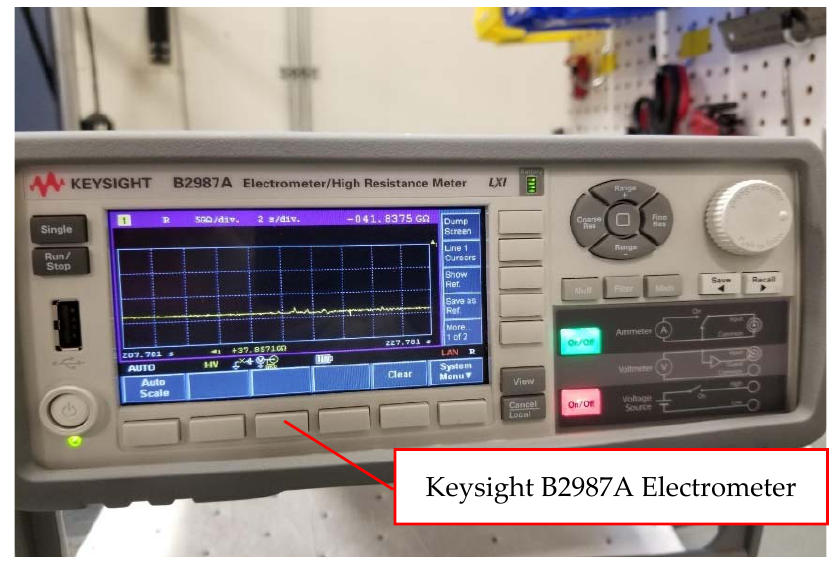
Figure 2. Keysight B2987A Electrometer (Reproduced with Permission, Courtesy of Keysight Tech- nologies, © Keysight Technologies, Inc., Santa Rosa, CA, USA) [34] for measurement of the electrical property of the test